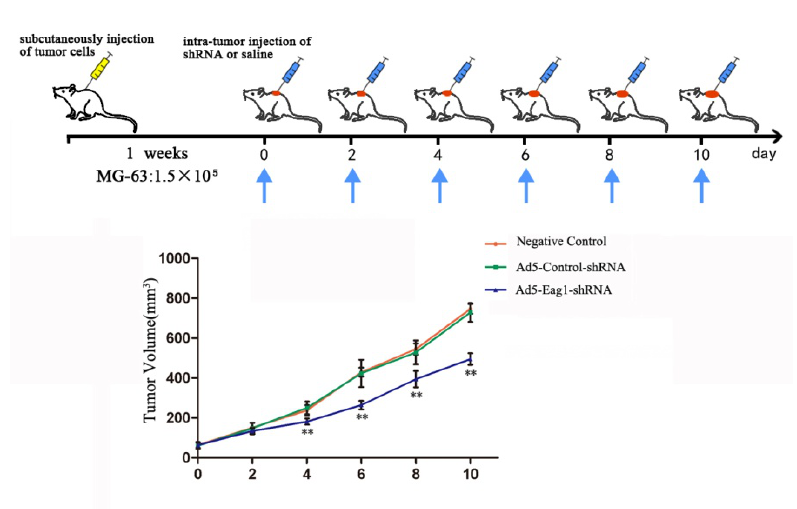
Figure 3. Ad5-Eag1-shRNA inhibits OS growth in vivo. ( A ) Schematic representation of the experiments with OS xenograft tumors and different treatments. Xenograft tumors were established by subcutaneous injection of 1 × 10 5 MG-63 cells. After one week, the tumors grew to visible size. Ad5-Eag1-shRNA treatment was given by intra-tumor injection every two days (blue arrows). Mice in the control group were injected with saline or Ad5-Control-shRNA; ( B ) The length and width of tumors were measured every two days after inoculation and the volume of tumor was calculated. After 10 days, the tumor volume growth curve was drafted. ** p < 0.01 vs. saline or Ad5-Control-shRNA